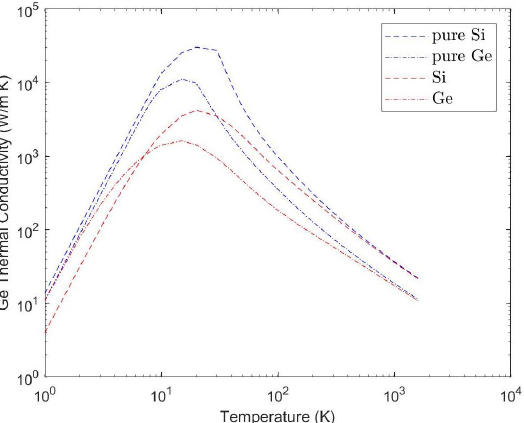
Figure 2. Pure silicon and germanium conductivities vs.